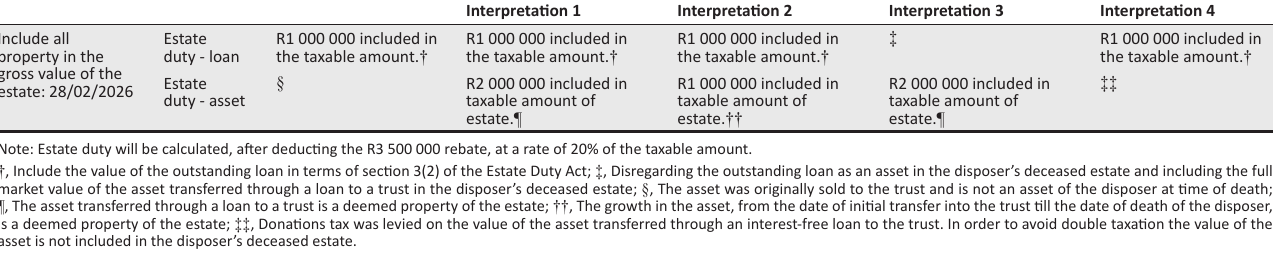
TABLE 2: Tax effect of the scenario on the disposer’s deceased estate’s tax calculation: Illustrating current tax effect and proposed tax effect per tax type on the disposer’s deceased estate’s tax calculation per transaction for the given scenario. Note Tax type